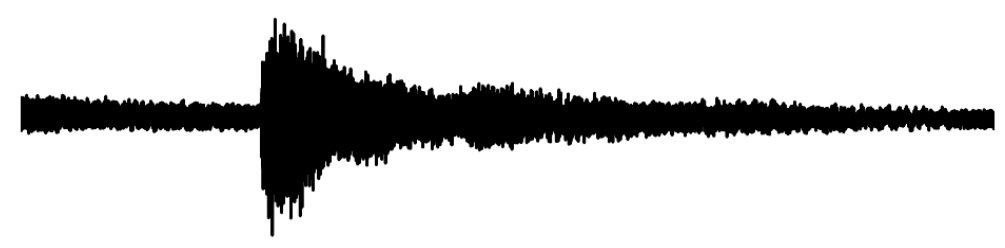
Figure 19. Impulse response with initial section low on perceptual features, transient occuring later in the